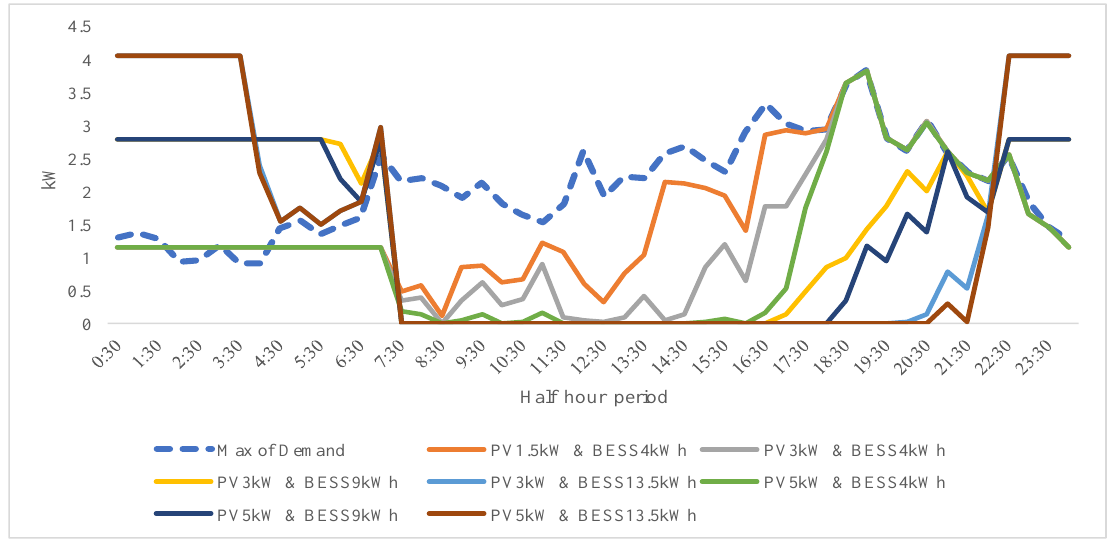
Figure 10. Maximum demand by equipment mix.